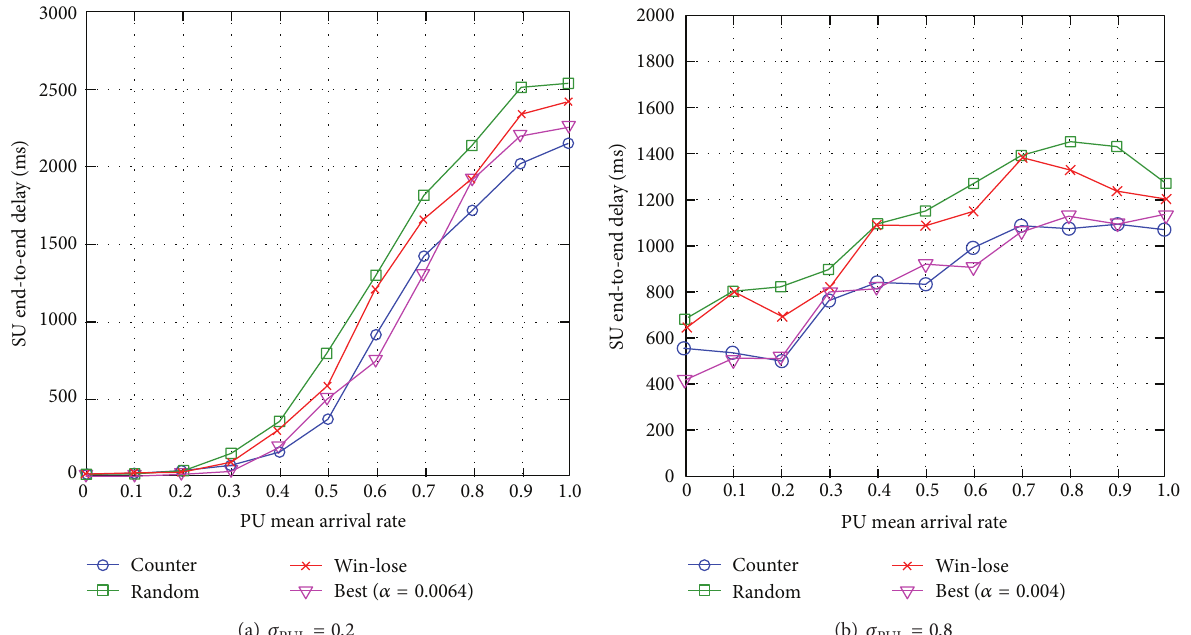
Figure 17: SU end-to-end delay for varying PU mean arrival rate 𝜇